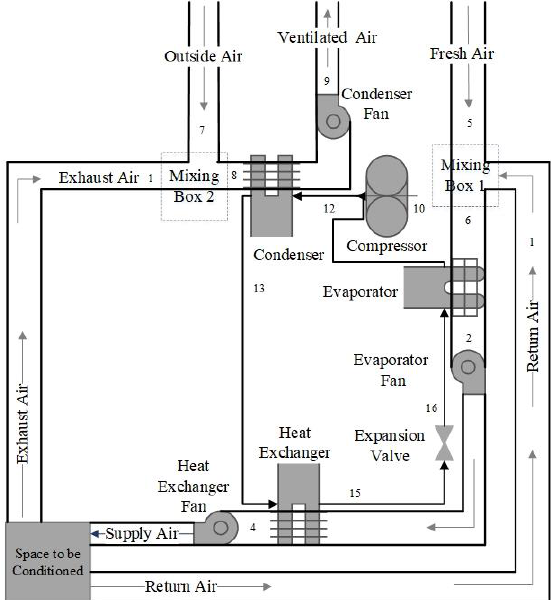
Figure 1. Proposed air dehumidification system equipped with an auxiliary heat exchanger and a mixing